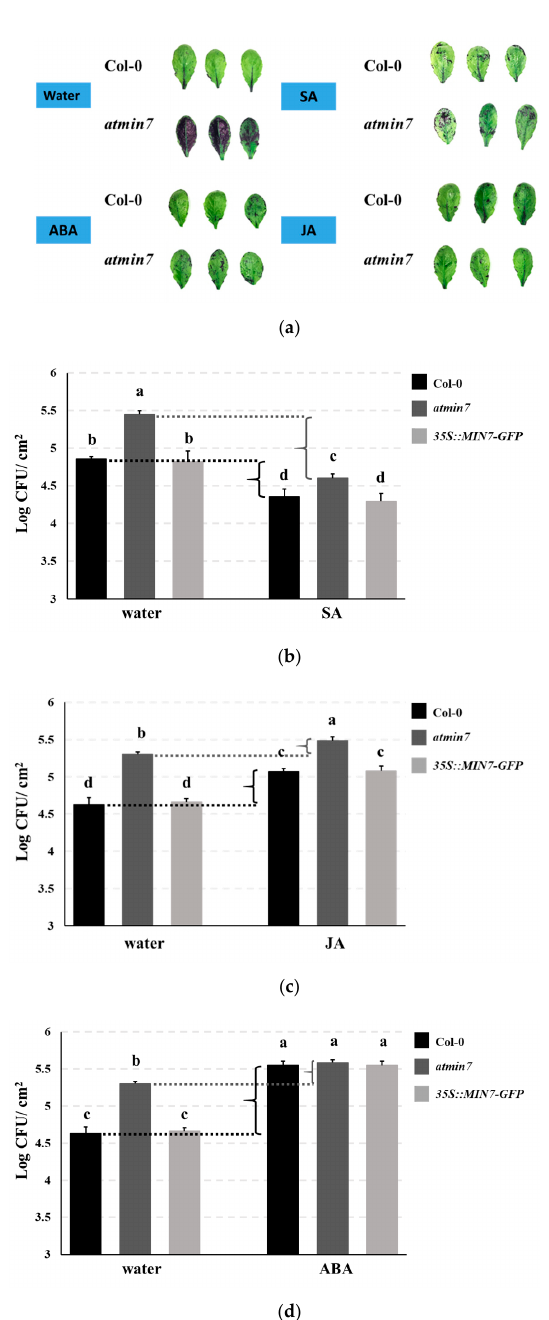
Figure 6. The plant hormones SA, JA, and ABA rescue cuticle formation and defense against the surface infection with Pto DC3000 in atmin7 mutant plants. ( a ). Leaves of four-week-old WT or atmin7 plants were stained with TB 24 h after the spray treatment with water, SA (1mM), JA (50 µ M), ABA (50 µ M). 100% EtOH (500 µ L) was firstly used to dissolve SA, JA, and ABA, which were further diluted with 1L distilled and deionized water to reach the final treatment concentration, respectively. Accordingly, 1L distilled and deionized water with an equivalent amount of 100% EtOH (500 µ L) was sprayed as the control. ( b – d ). WT, atmin7 , and 35S::MIN7-GFP plants were sprayed with water control and either SA ( b ), JA ( c ), or ABA ( d ) as in the panel. 24 h later, the plant leaves were spray inoculated with 1 × 10 8 CFU / mL of Pto DC3000. Three days later, the bacteria were enumerated. The experiment was repeated twice with similar results, and the mean +/ - SD of combined data from the two biological replicates are shown. Di ff erent letters a–d within figure ( b – d ) indicate the significant di ff erences at p < 0.05, which was calculated by one-way analysis of variance (ANOVA) using SPSS ver.